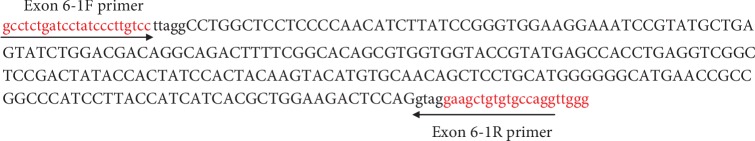
Nucleotide sequence of the amplified PCR product (275 bp) representing exon 6 of rat p53 gene in the HCC-induced group.